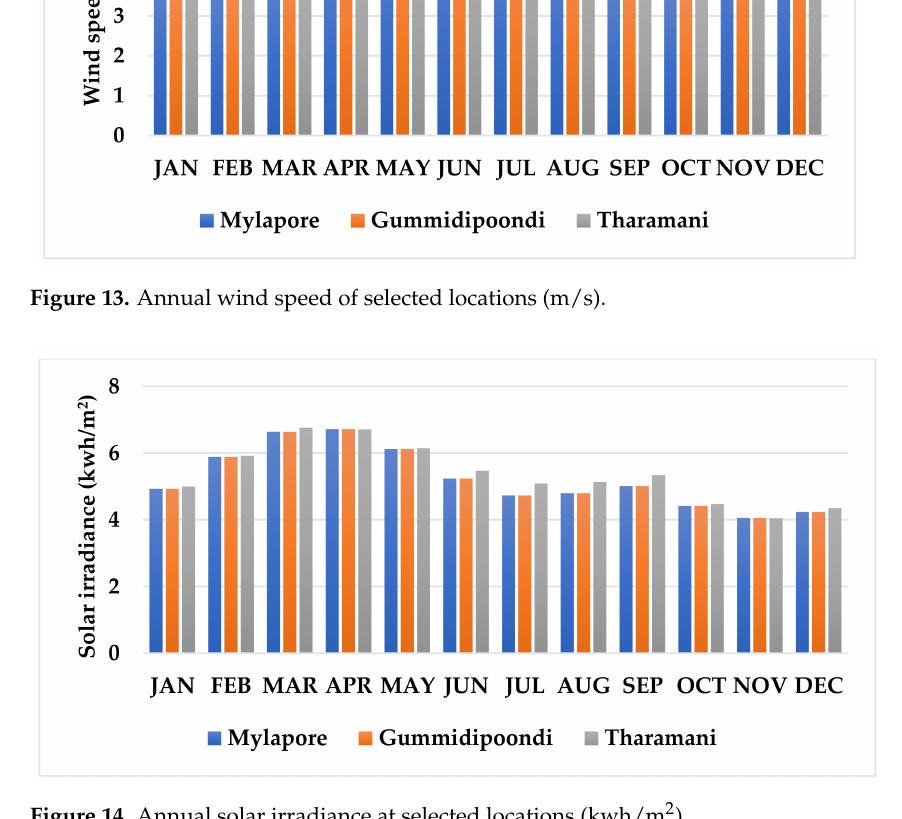
Table 12. Area-wise technical potential for wind and solar PV energy generation.